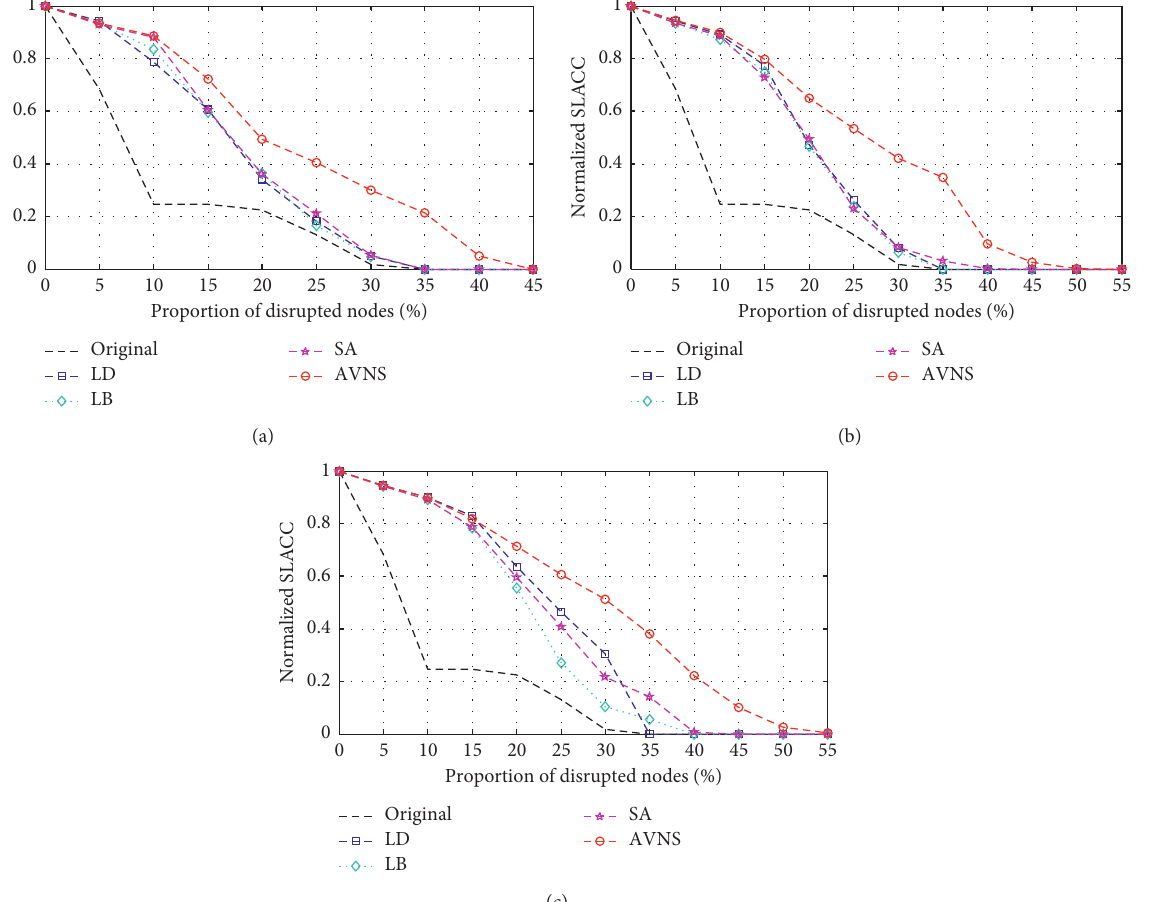
Figure 9: Response of chain 21 and reconfigured ones facing random disruptions. (a) f